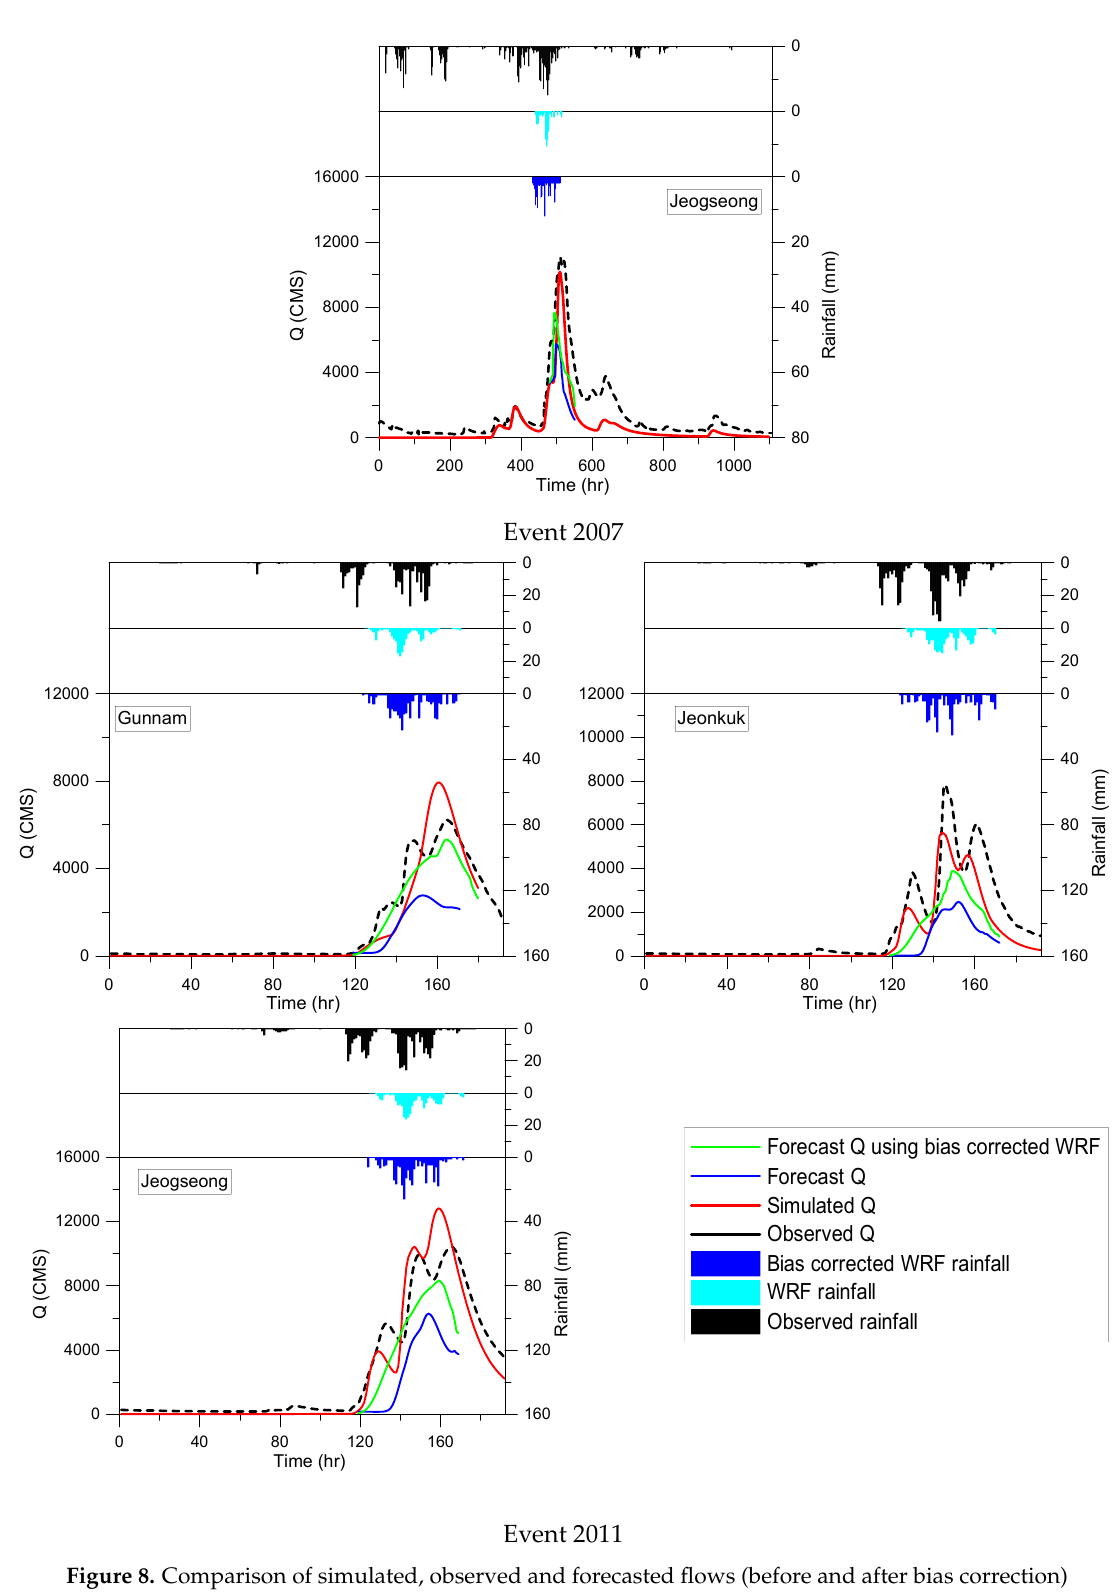
Figure 8. Comparison of simulated, observed and forecasted flows (before and after bias correction) and observed and forecasted rainfall (before and after bias correction) for 2002, 2007 and 2011 events.